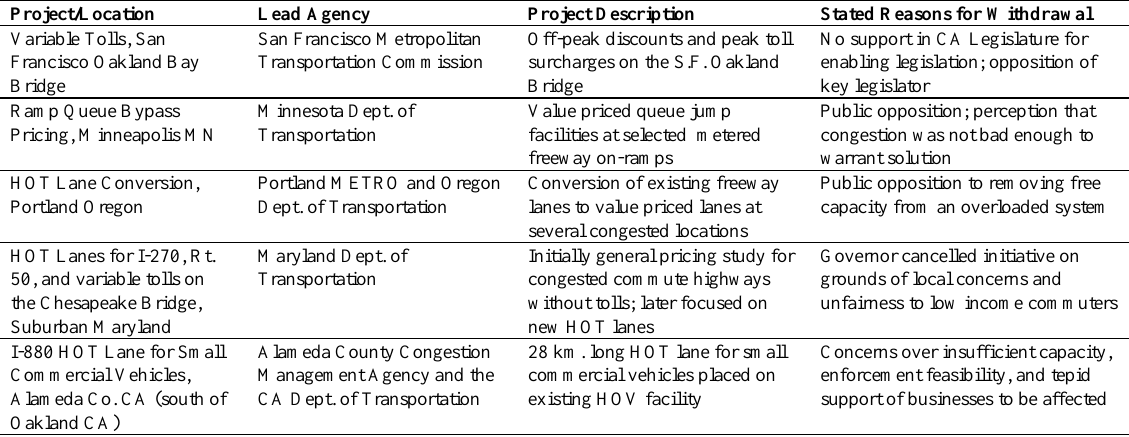
Table 4. Examples of Value Pricing Proposals